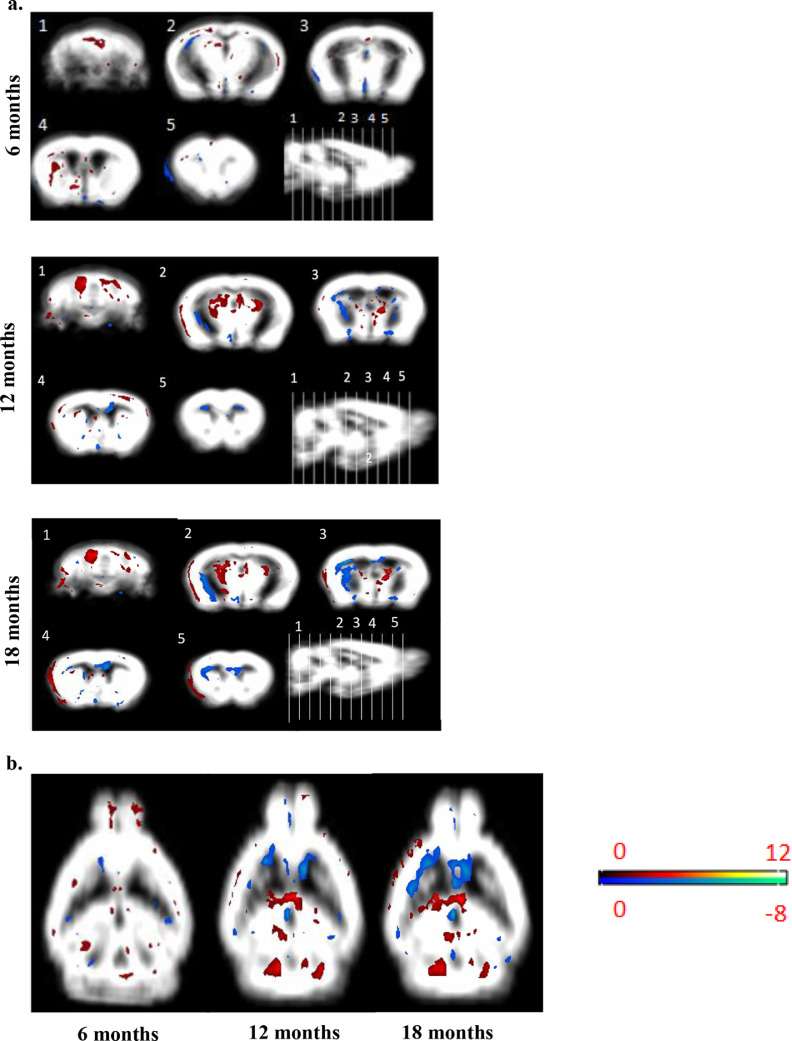
a,b: Presentation of the VBM results produced by the SPM12 software with the SPMMouse plugin for grey matter of control versus mdx at various time points. The grey matter average shown is for the control mice and a coloured overlay showing the location of significant clusters. Red clusters indicate where control mouse brain is larger than mdx brain and blue indicates where mdx brain is larger than control brain. Colour intensity on the scale bar refers to the level of significance with a lighter colour indicating a higher level of significance (p < 0.05, student's t-test). a. Coronal images numbered 1–5 with corresponding sagittal image detailed image plane. (Grey matter average is from 8 control mice). b. Axial grey matter slices detailing VBM findings.